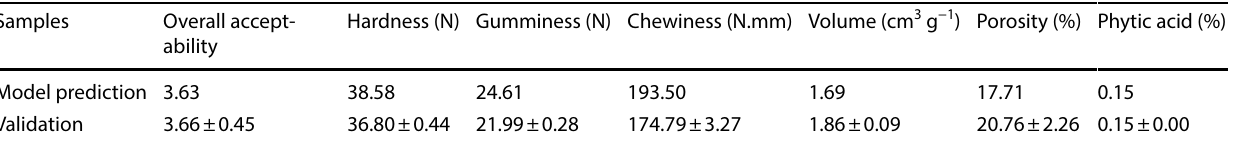
Table 5 Optimal conditions of fermentation for whole meal wheat-barely dough (50:50), (Result of model prediction and validation tests) Samples Overall accept- ability Model prediction